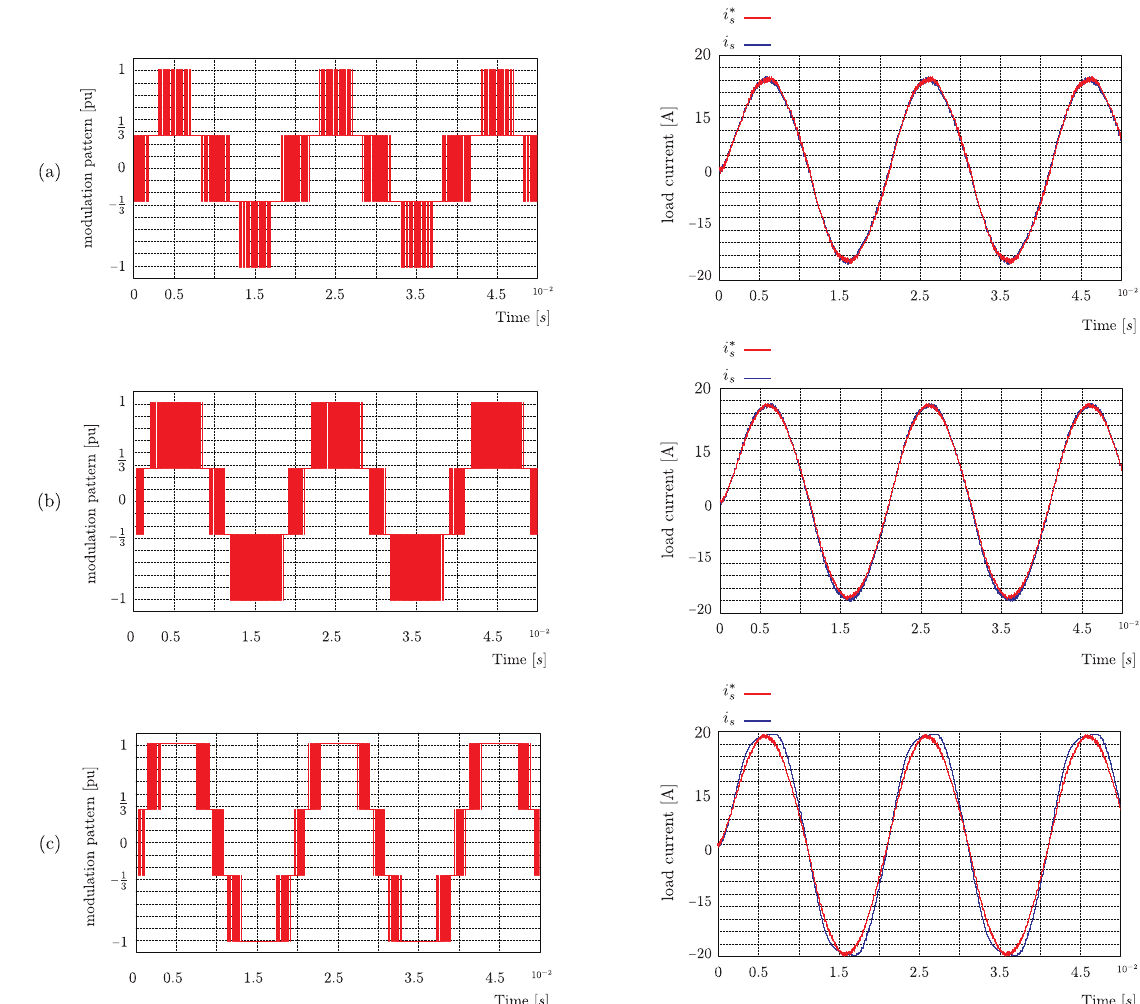
Figure 9. Simulation results. Inverter voltage and load current with modulation index in the linear range m = 0.5 ( a ), m = 0.8 ( b ) and in the over-modulation region m = 1.5 ( c ).